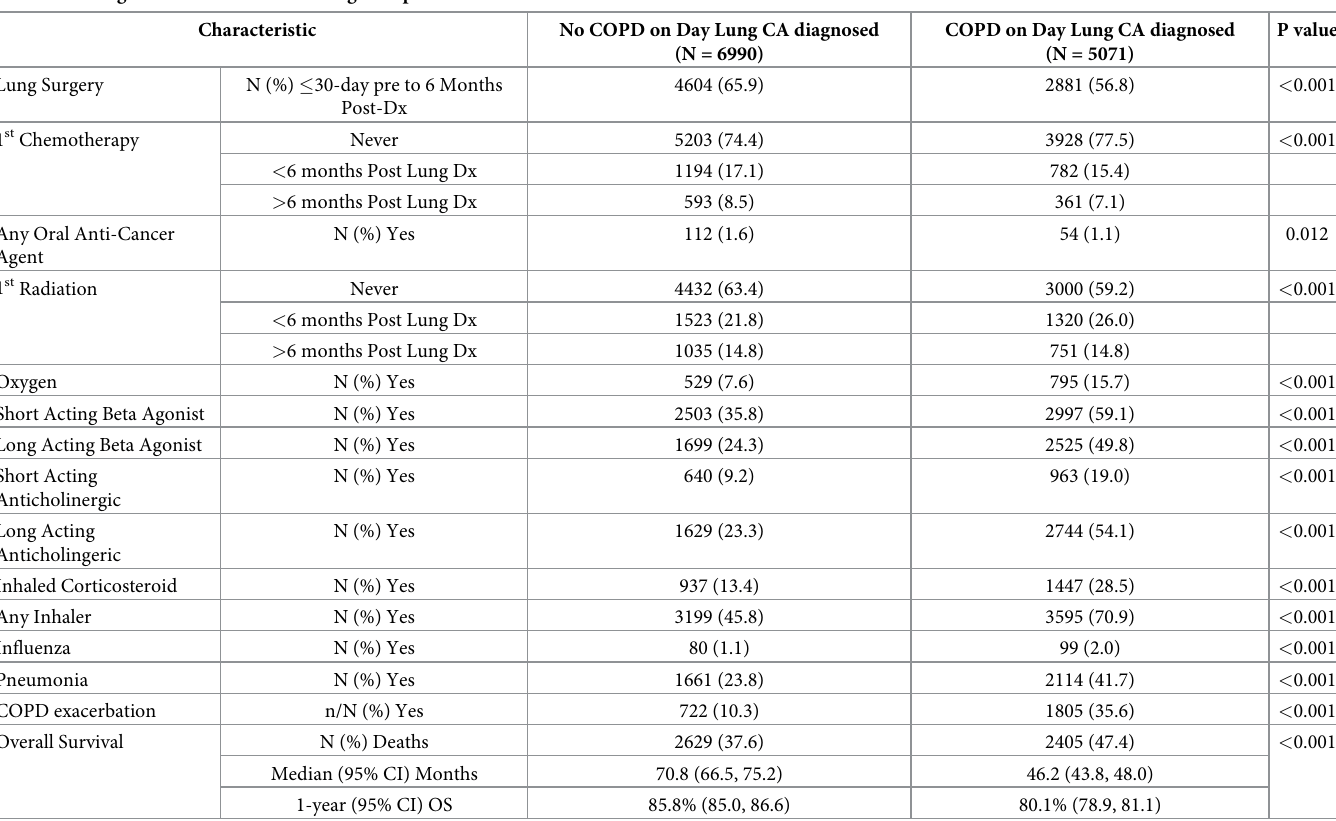
Table 2. Management and outcomes of stage I/II patients.